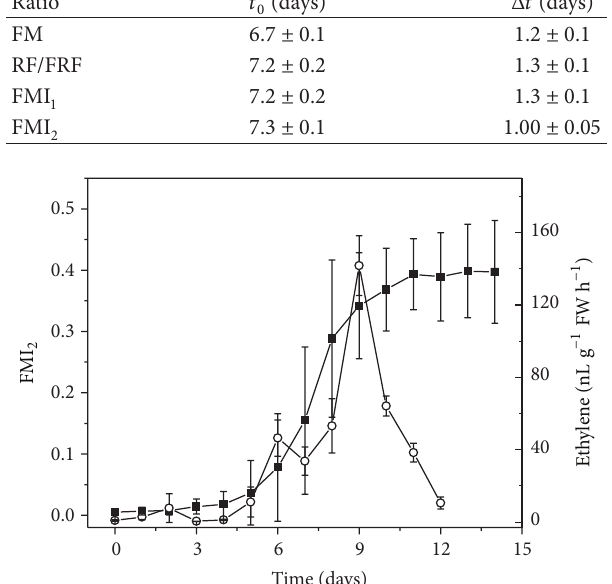
Figure 4: FMI 2 time evolution (black square—left axis) and the ethylene time evolution (white circle—right axis) from [10].